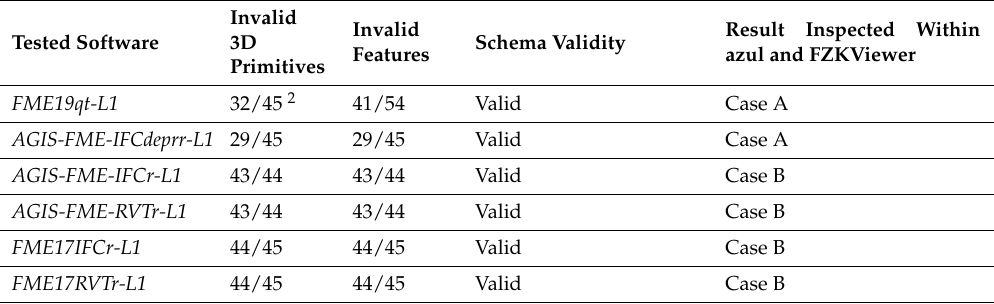
Table 10. Analysis of the IFC4 geometries, in IFC v.4 dataset converted to CityGML. 1 Invalid Tested Software 3D